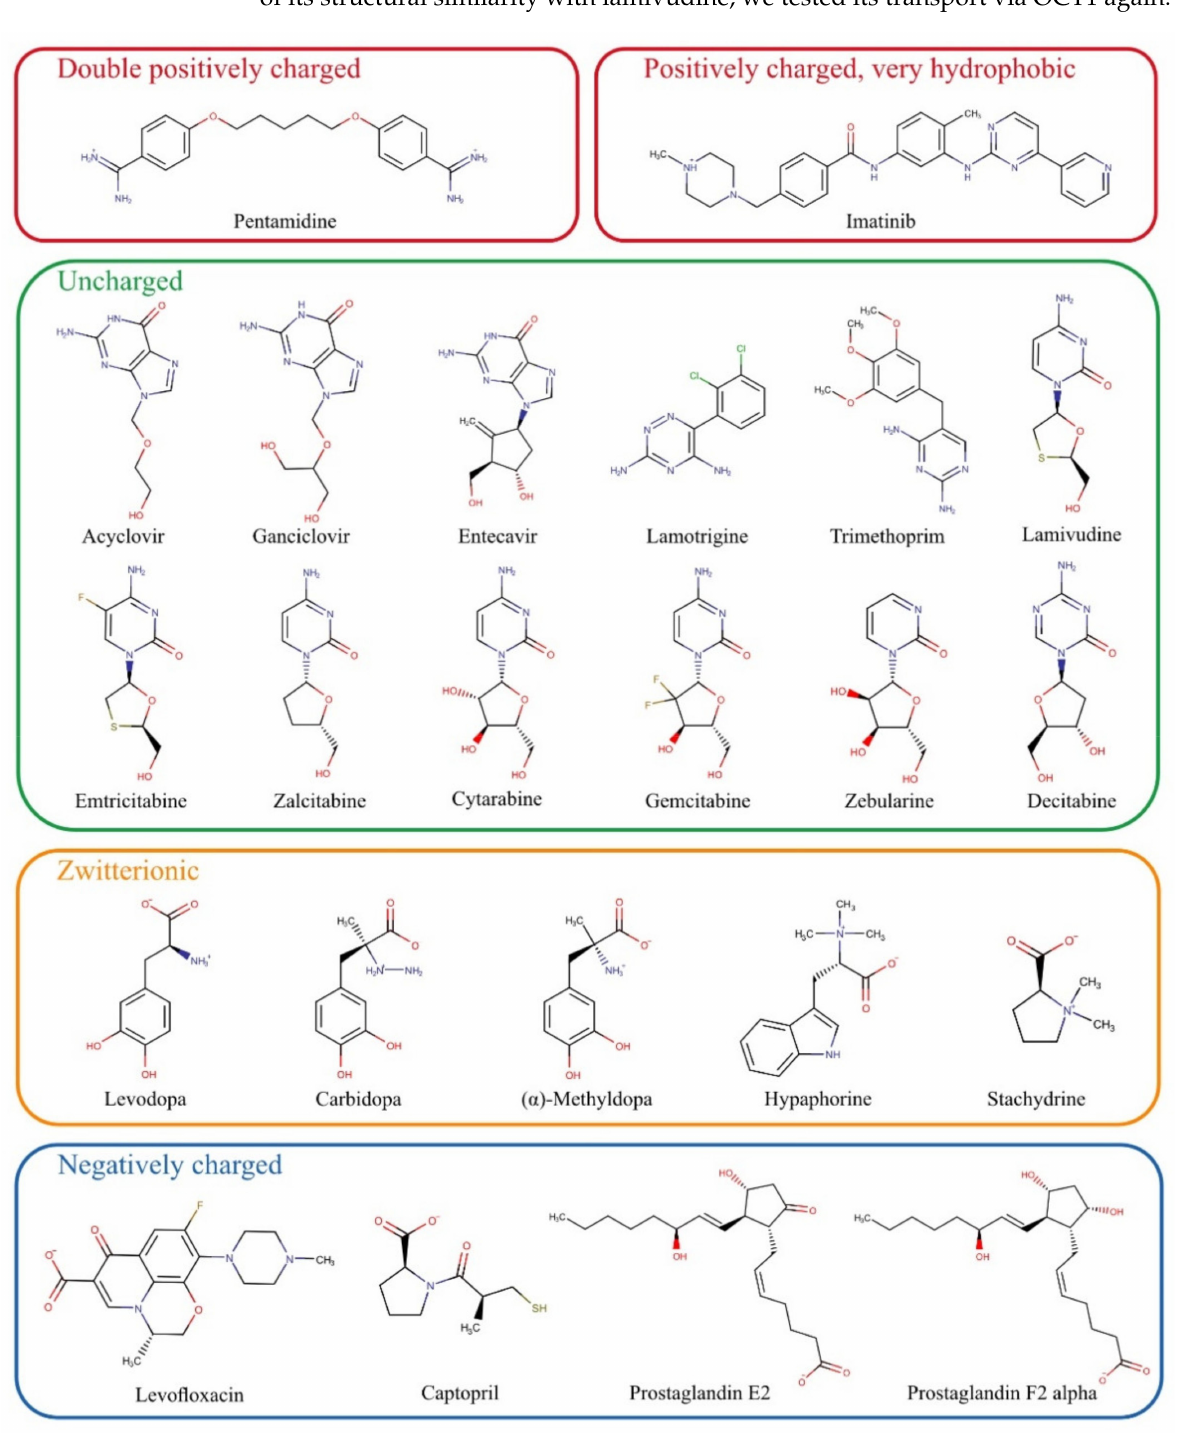
Figure 2. Chemical structures of potential substrates of OCT1 investigated in this study grouped by their charge at physiological